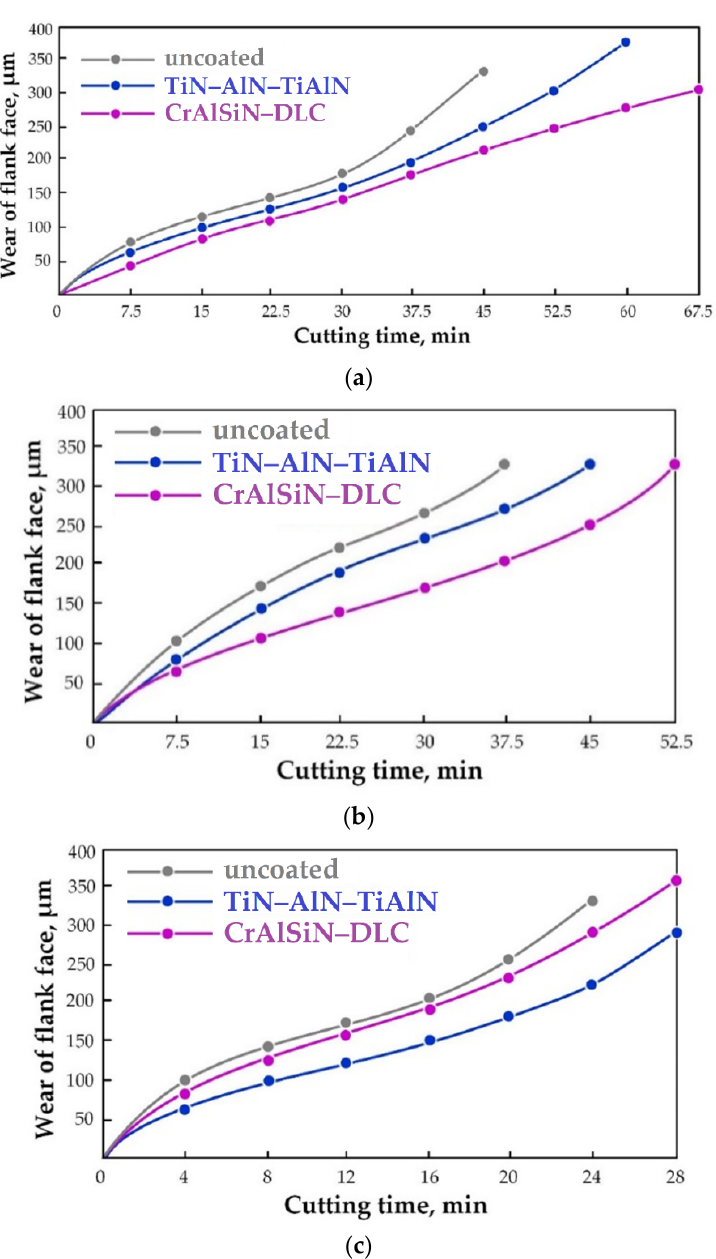
Figure 8. Dependences of the flank wear of ball end mills with different coatings on the machining time of the nickel alloy at different cutting speeds: ( a ) 150 m/min; ( b ) 200 m/min; ( c ) 250 m/min.